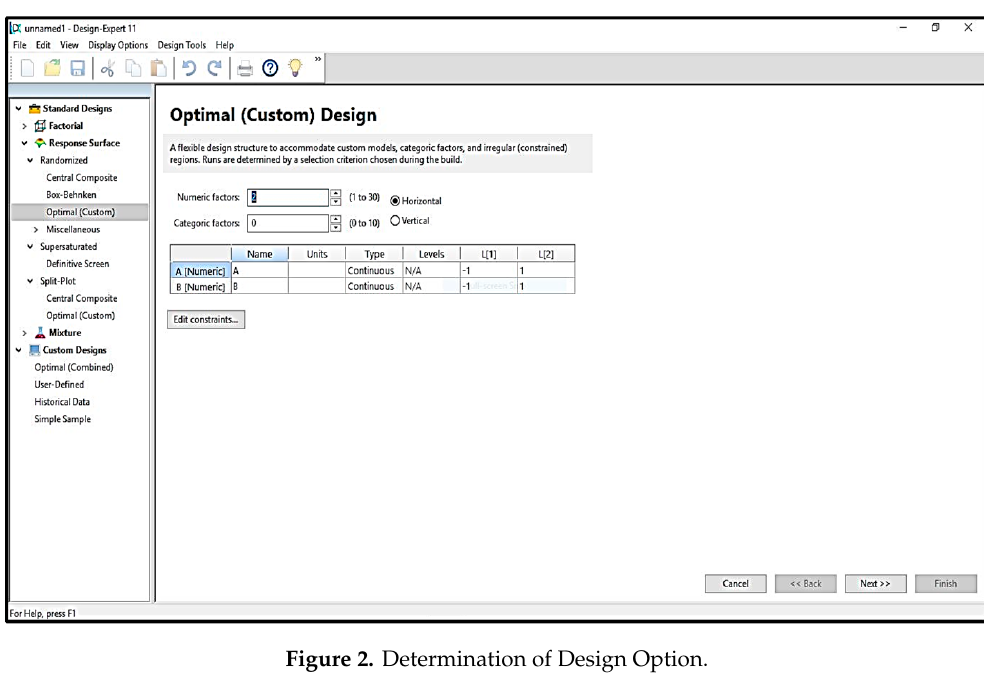
Figure 2. Determination of Design Option.